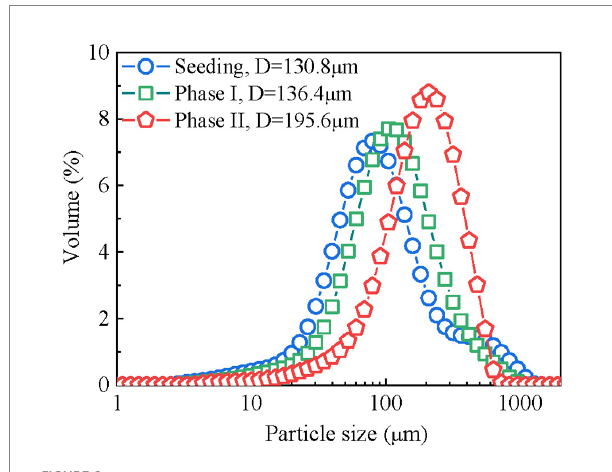
FIGURE 6 Variation in sludge size distribution in the mainstream anammox